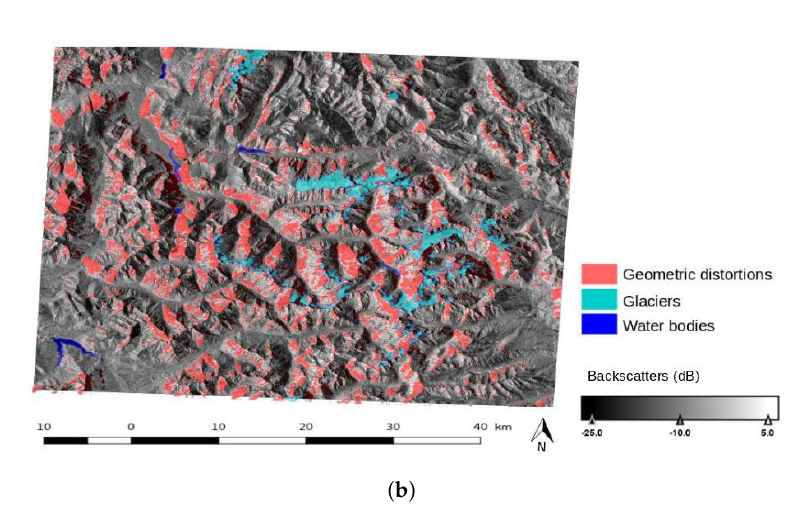
Figure 3. Areas affected by the geometric distortions: ( a ) 13 February 2017, descending orbit; and ( b ) 14 February 2017, ascending